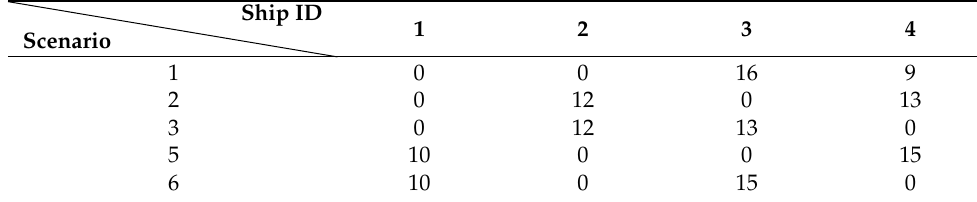
Table 6. Example 1—final results of the duration (h).